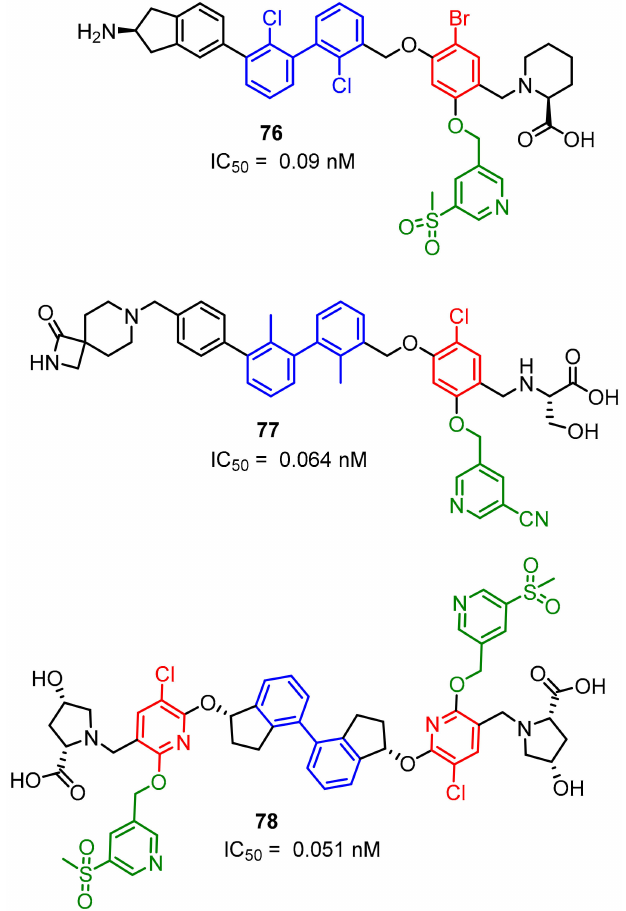
Figure 32. Compounds reported by Aktoudianakis et al. [87] (Gilead Sciences).